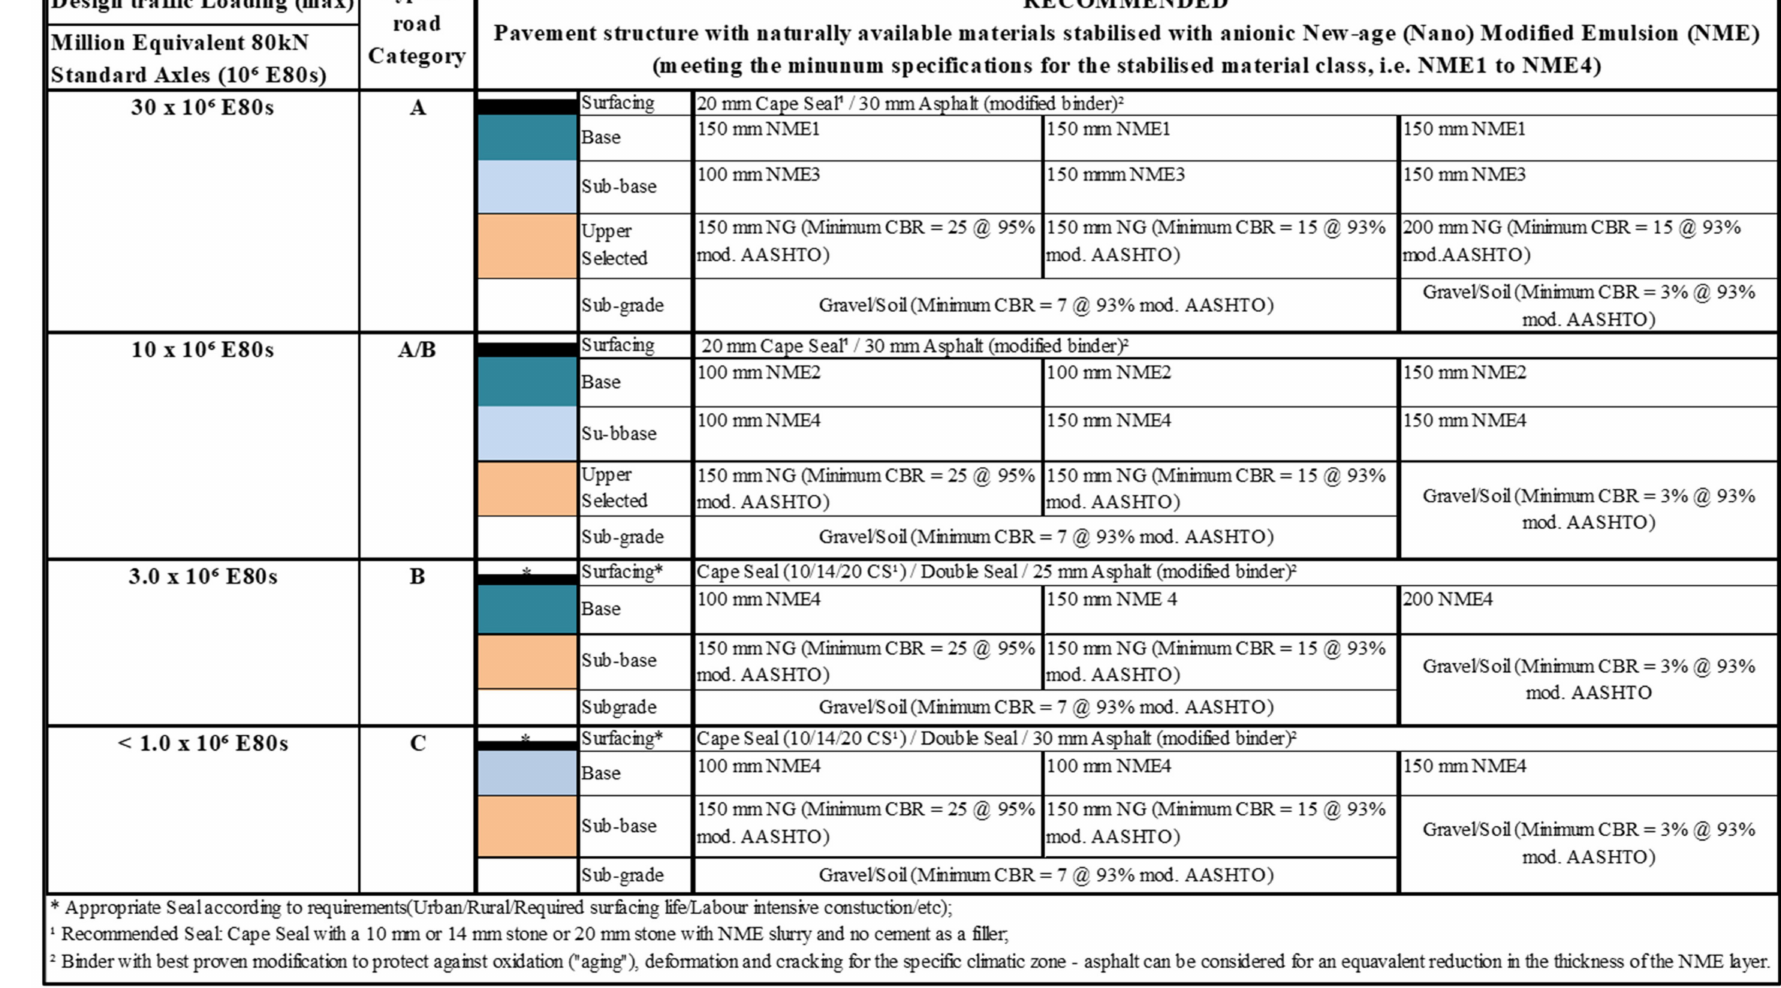
Figure 26. Typical recommended pavement structures developed for the construction of road pavements using a material compatible anionic New-age (Nano) Modified Emulsion (NME) stabilising agent with naturally available materials as per specifications (Figure